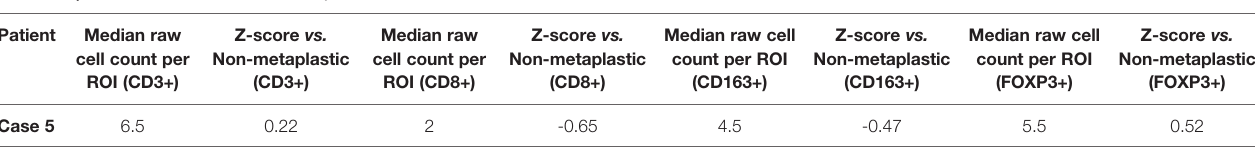
TABLE 3 | Immune cell counts in Case 5 by